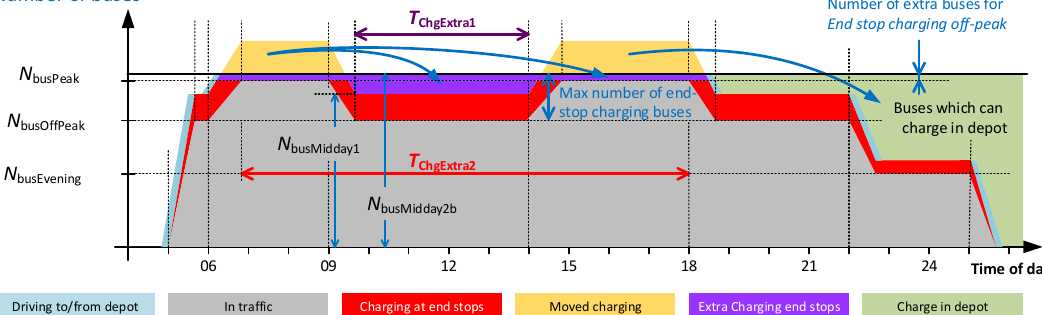
Figure 9. How the number of buses during peak traffic can be reduced by moving charging to other times, when the off ‐ peak traffic is almost as high as the peak traffic.